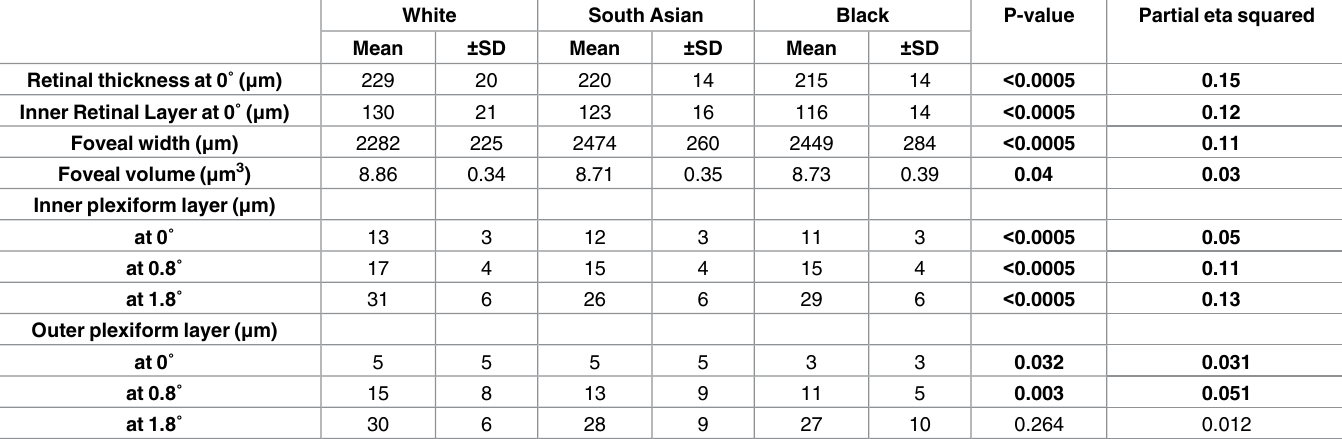
Table 2. Mean ± SD retinal thickness, foveal width and foveal volume, inner and outer plexiform layers per ethnic group and results of two-way analysis of covarianceshowing between-subjects effects of ethnicity with mean spherical error as covariate (results for gender analysis not